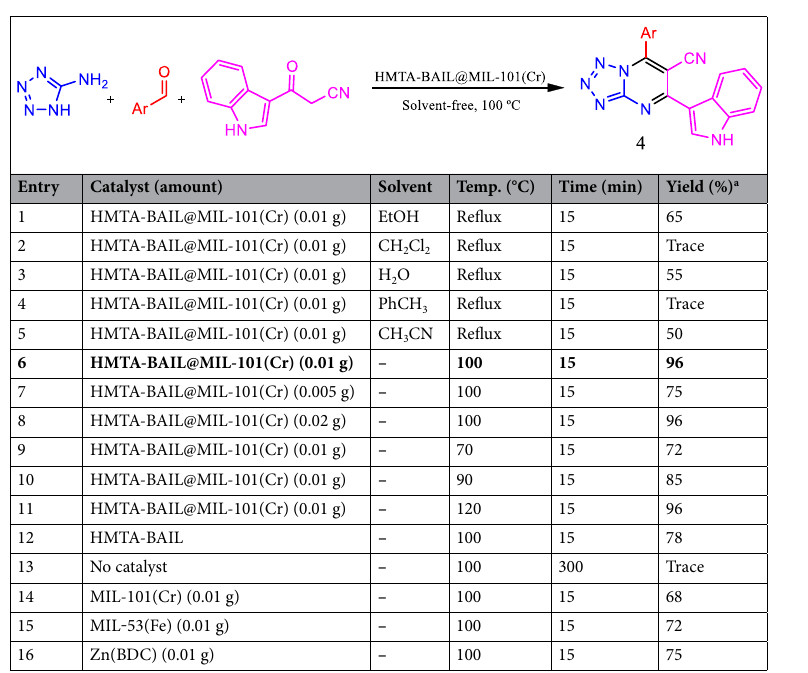
Figure 7. TEM images of HMTA-BAIL@MIL-101(Cr).